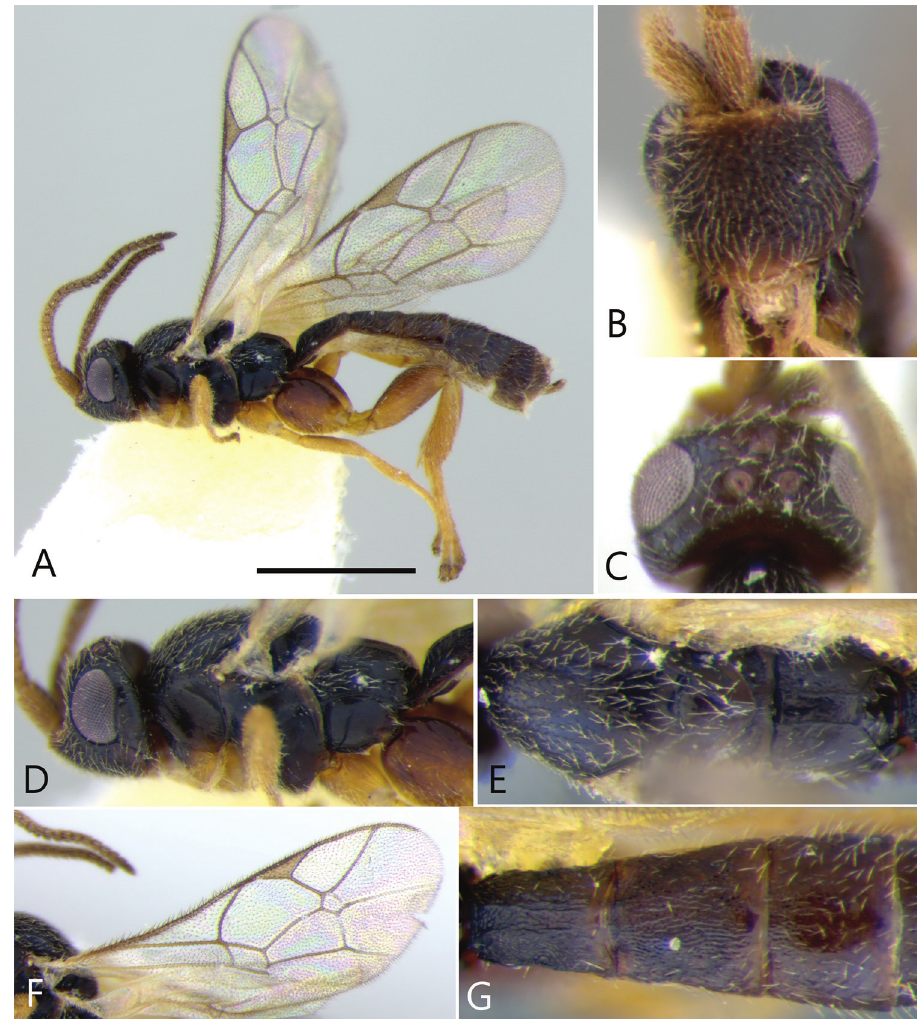
Figure 18. Orthocentrus trichoptilus sp. nov. Holotype. A Habitus in lateral view B head in frontal view C head in dorsal view D head and mesosoma in lateral view E mesosoma in dorsal view F fore wing G first to third tergites in dorsal